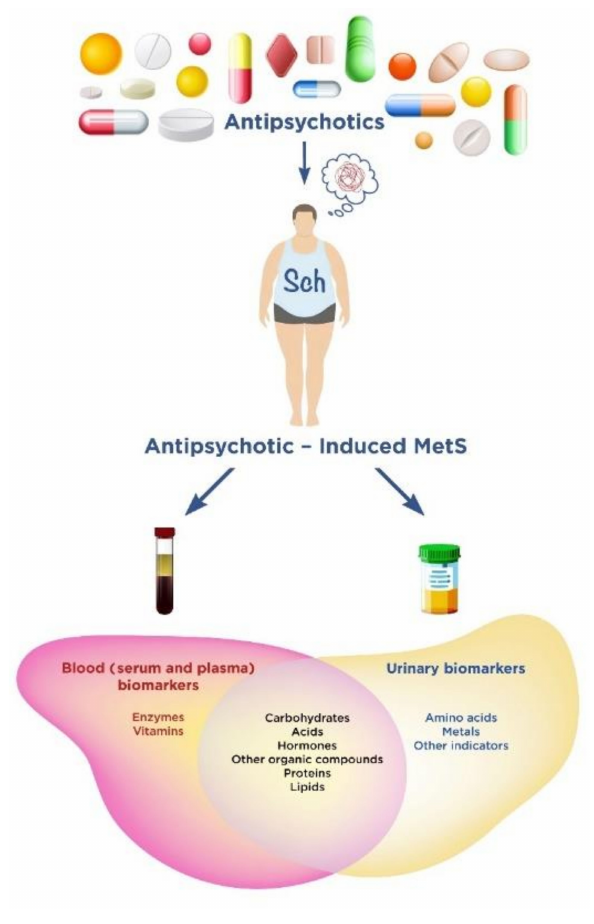
Figure 1. Potential Blood (Serum and Plasma) and Urinary Biomarkers of Antipsychotics—Induced Metabolic Syndrome (AIMetS) in Patients with Schizophrenia